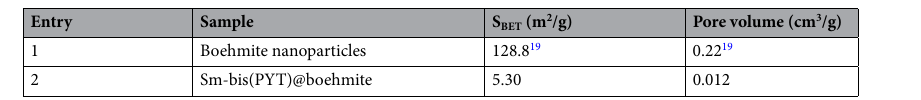
Table 2. Textural properties of boehmite nanoparticles and